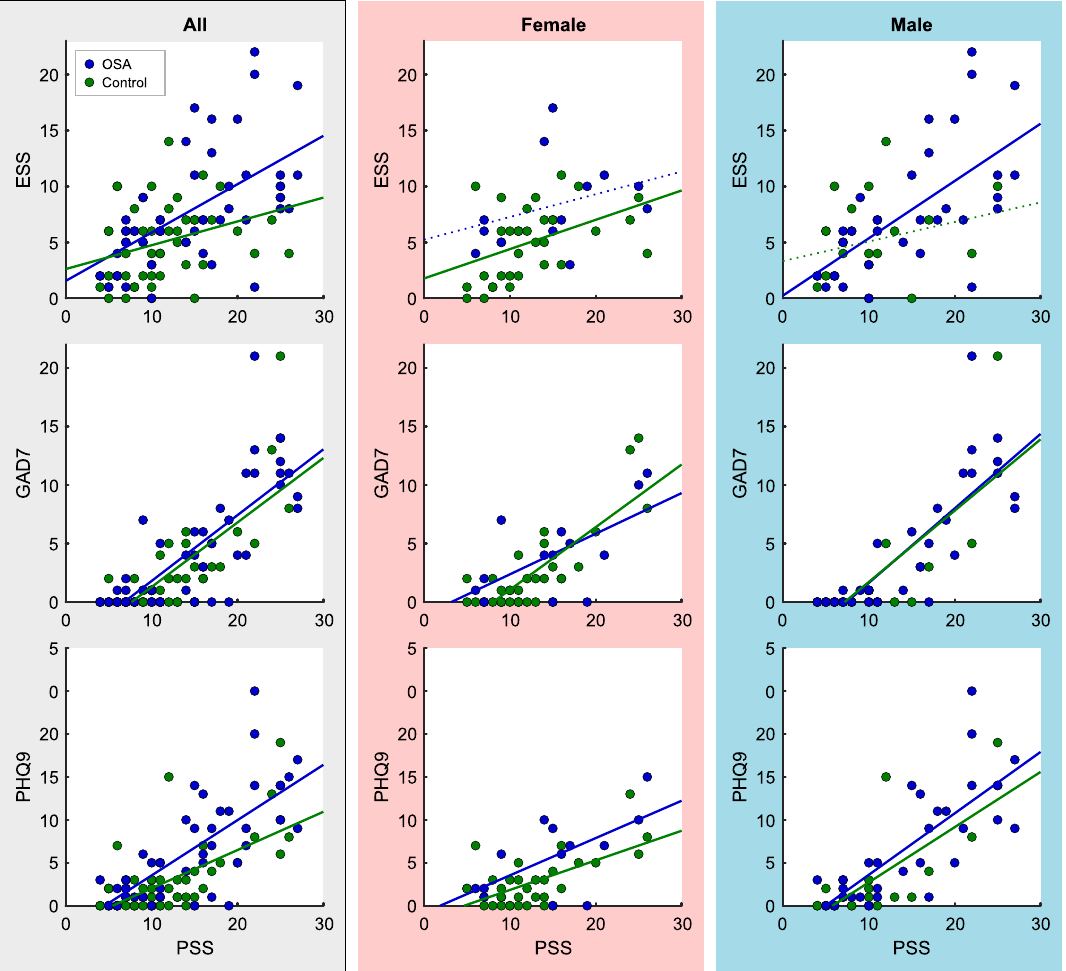
Figure 2. Symptoms vs. stress in OSA. Scatterplots of excessive daytime sleepiness (ESS), anxiety symptoms (GAD-7), and depressive symptoms (PHQ-9) versus stress (PSS) for combined sexes (All; left gray column), females (middle red column) and males (right blue column). Control values are green and OSA blue. Trend lines (with non-zero intercept) are plotted, with significant relationships indicated by solid ( P ≤ 0.05) vs dashed ( P > 0.05) lines. PSS = Perceived Stress Scale; GAD-7 = Generalized Anxiety Disorder scale; PHQ-9 = Patient Health Questionnaire; ESS = Epworth Sleepiness